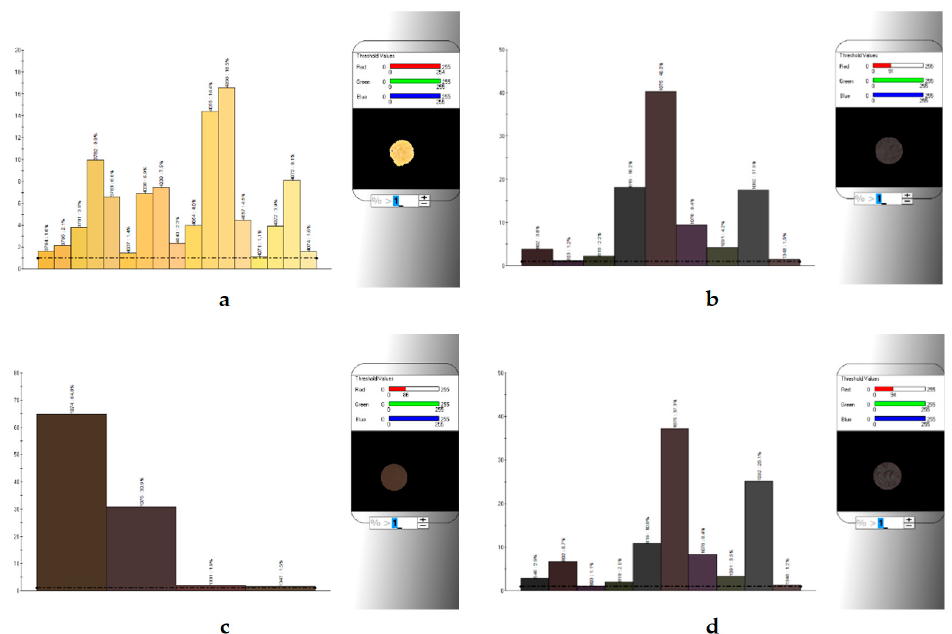
Figure 7. Detailed color analysis of white garlic and black garlic products using the instrumental method (“electronic eye”). ( a ) WG—white garlic, ( b ) BG-C—black garlic cloves, ( c ) BG-P—black garlic powder, ( d ) BG-S—black garlic spread.